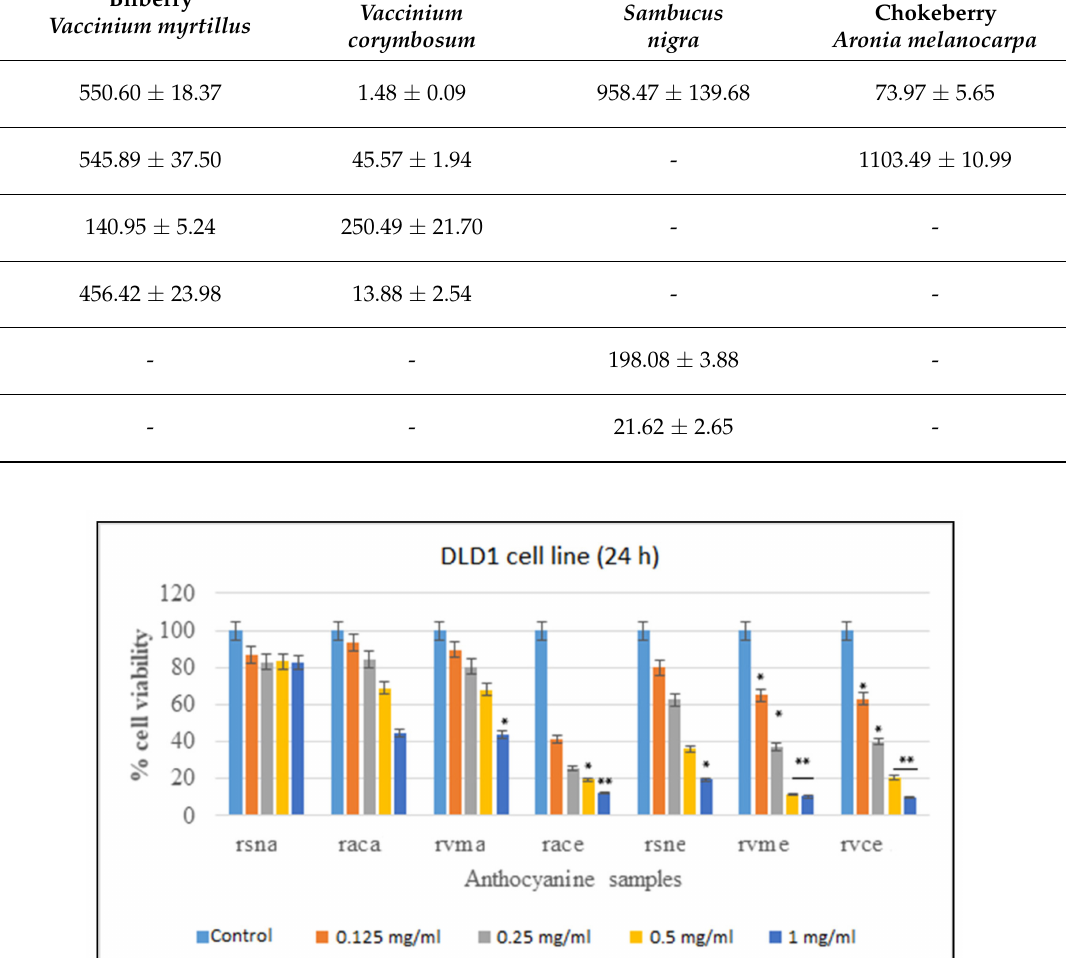
Compound Assigned